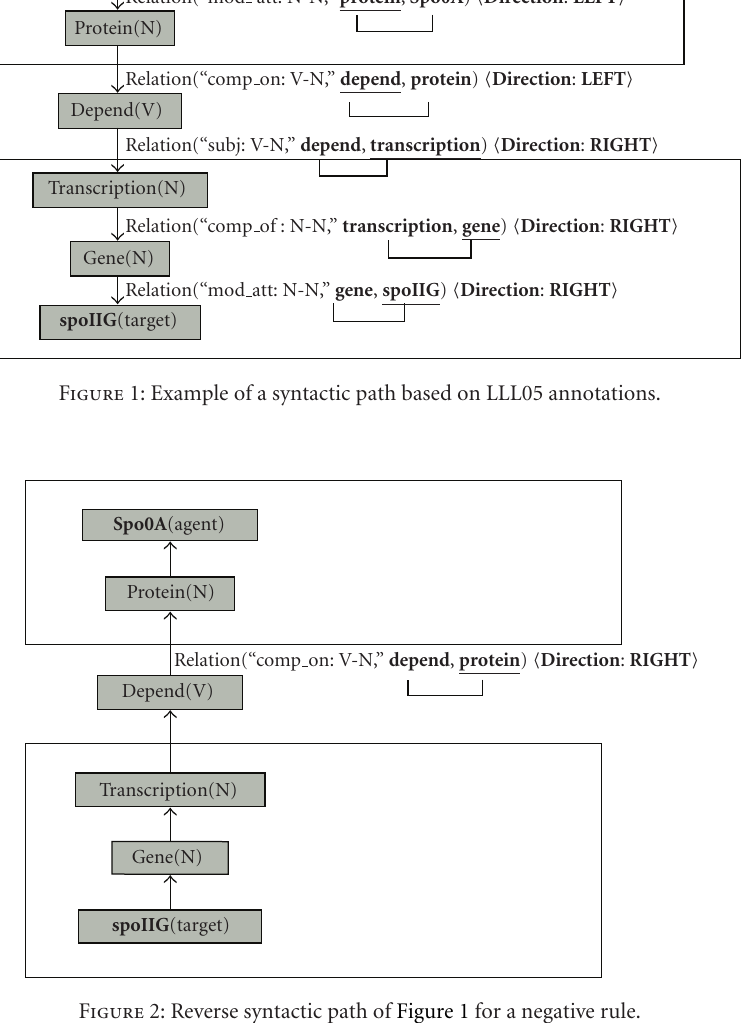
Figure 2: Reverse syntactic path of Figure 1 for a negative